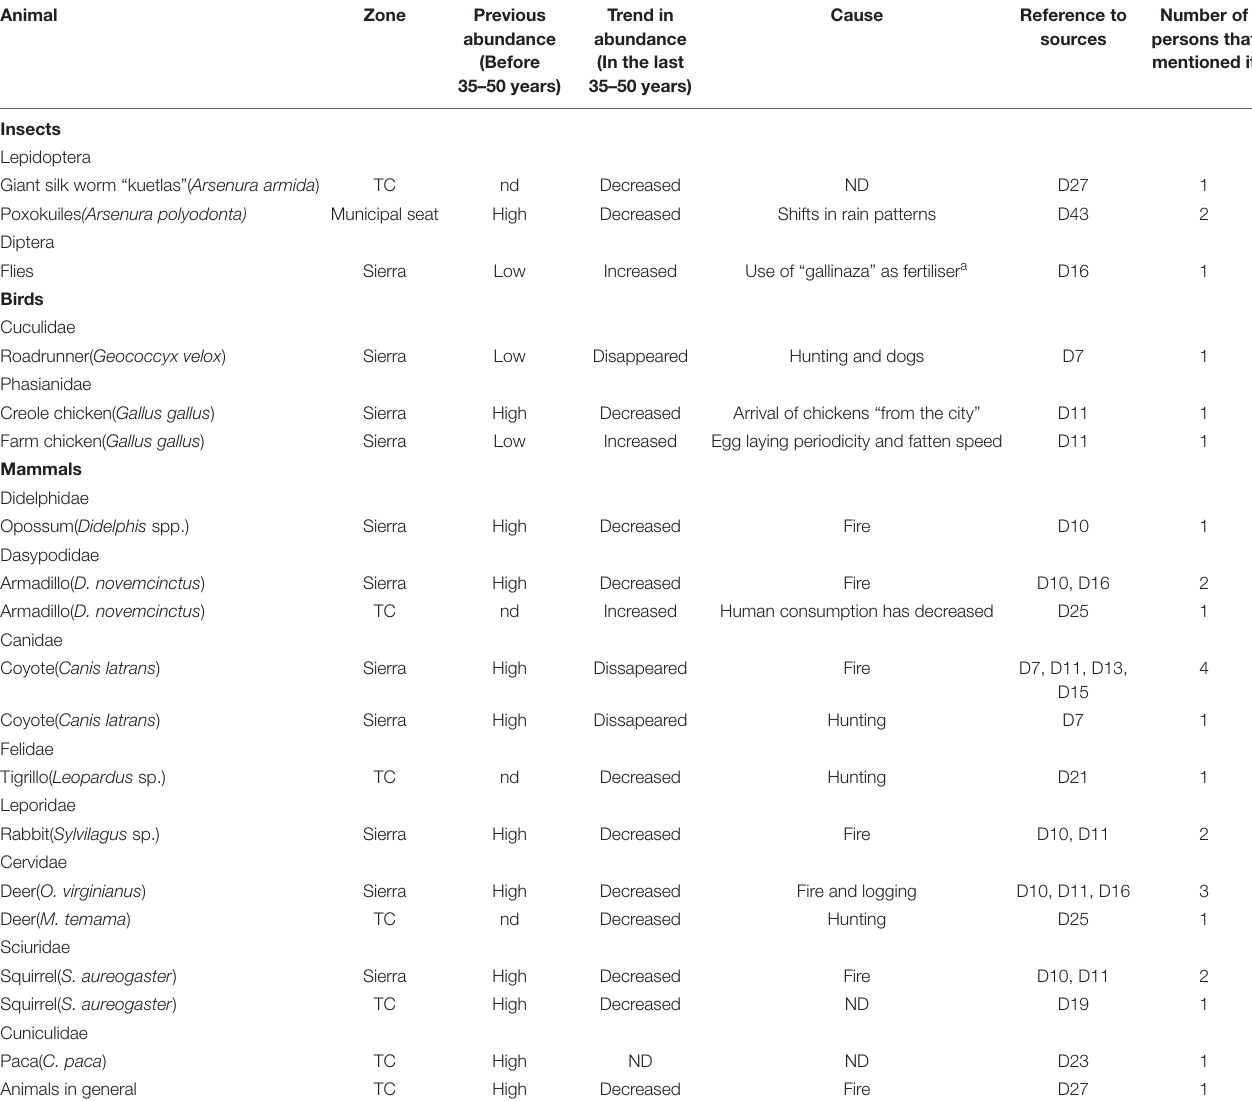
TABLE 6 | Trends in animal’s abundance and their causes, as reported in adults’ interviews. Animal